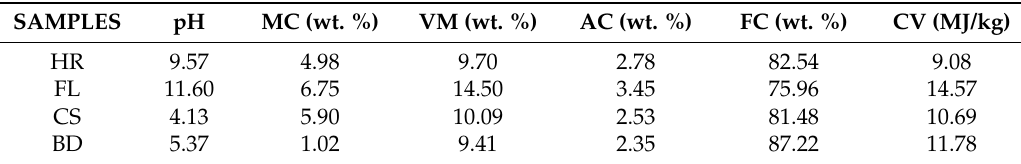
Table 3. Proximate Analysis of Pretreated Waste Samples Result.